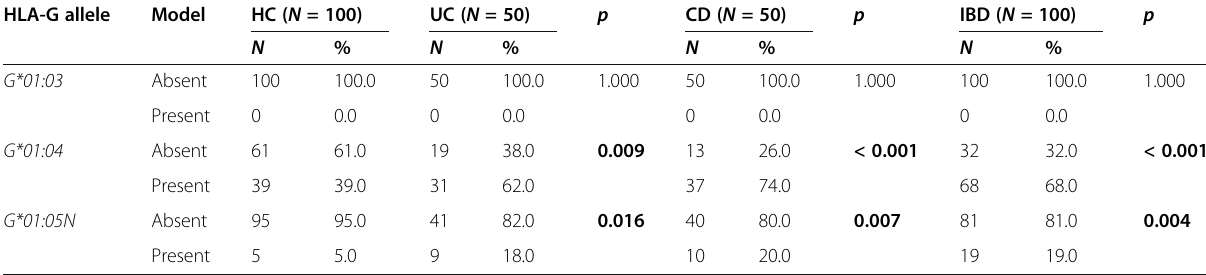
HC healthy controls, UC ulcerative colitis, CD Crohn ’ s disease, IBD inflammatory bowel disease, p two-tailed Fisher exact probability compared to controls (significant p value is indicated in bold)